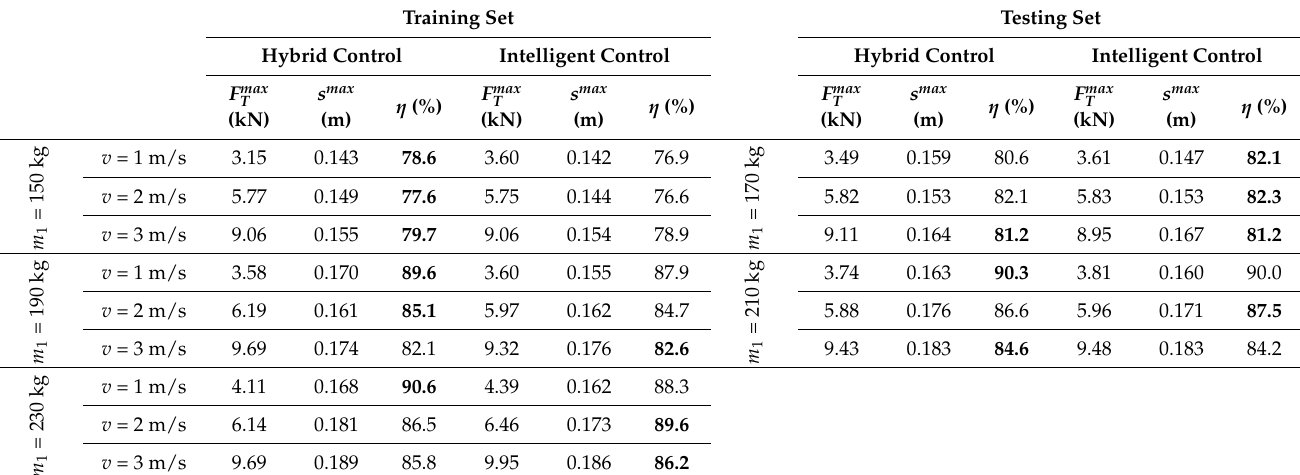
Table 3. Damper performance using the hybrid controller with exact information and intelligent controller in training and testing cases. The best efficiency for each case is marked in bold.